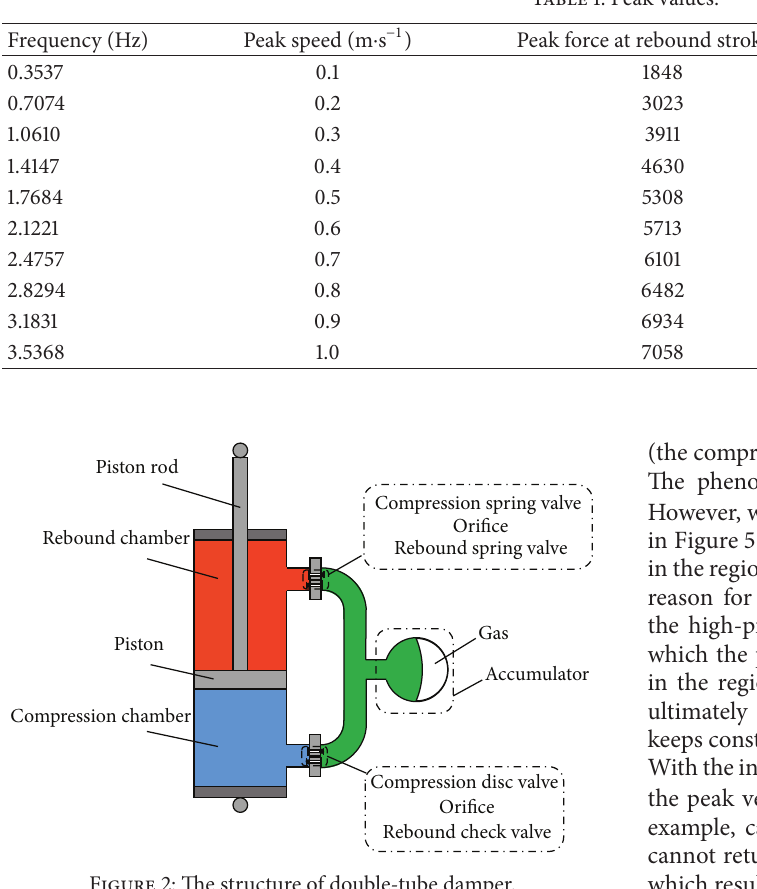
is not high enough to open the high-pressure valves (the compression disc valve and the rebound spring valve) and the fluid flows via only the orifice and low-pressure